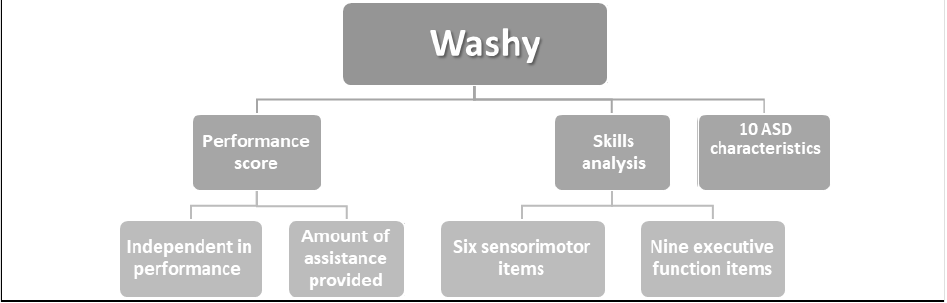
Figure 1. The Do-Eat Washing Hands Structured Observation